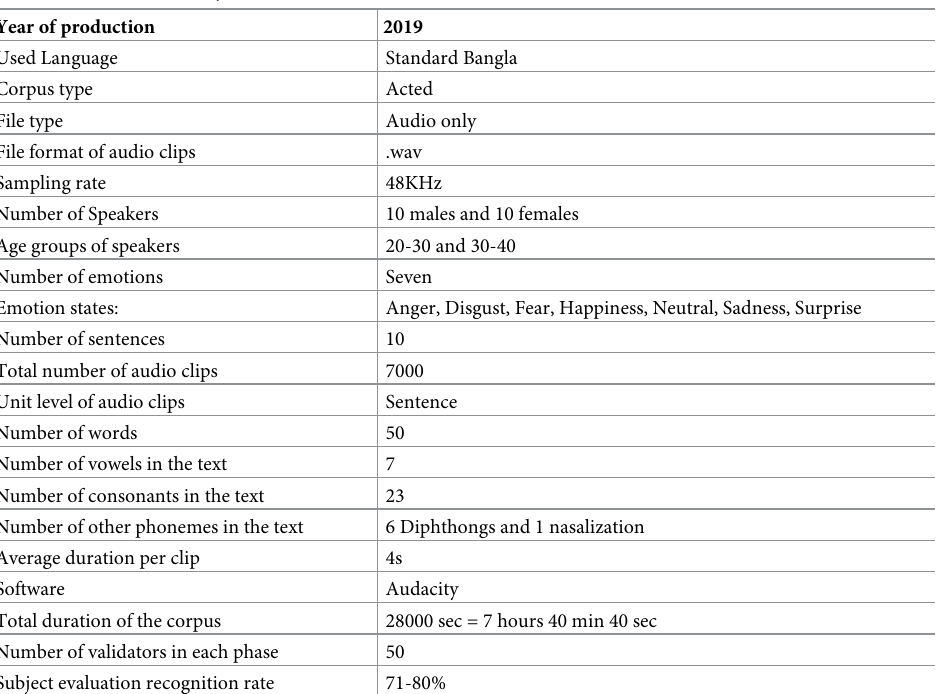
Table 1. Database